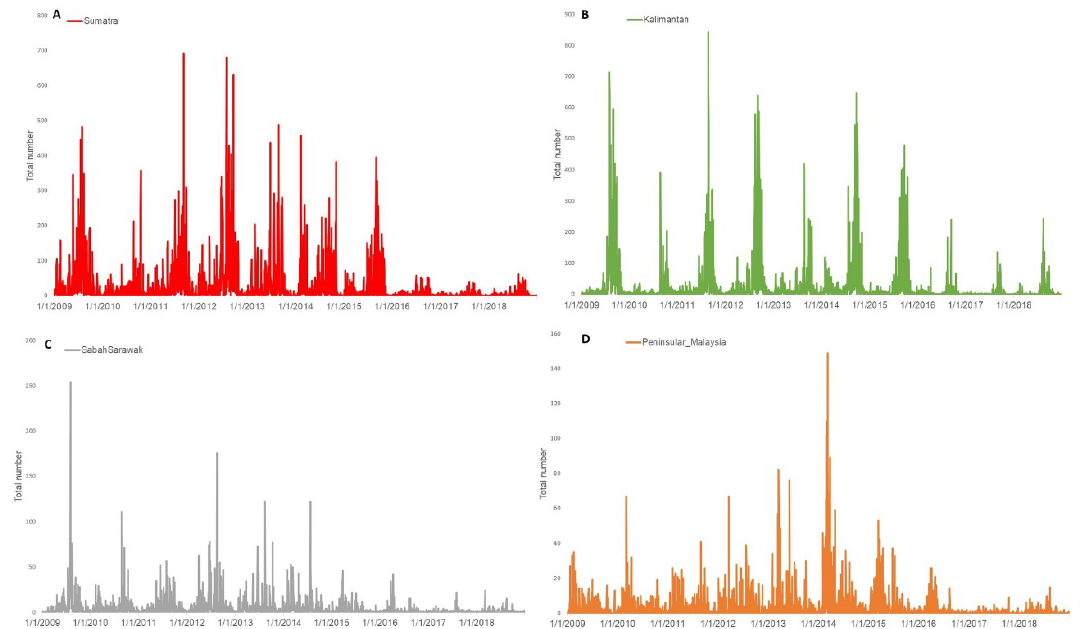
Figure 3. Daily distribution of forest fires hotspots counts ( A ) Sumatra ( B ) Kalimantan ( C ) Sabah / Sarawak ( D ) Peninsular Malaysia from 2009 to 2018.